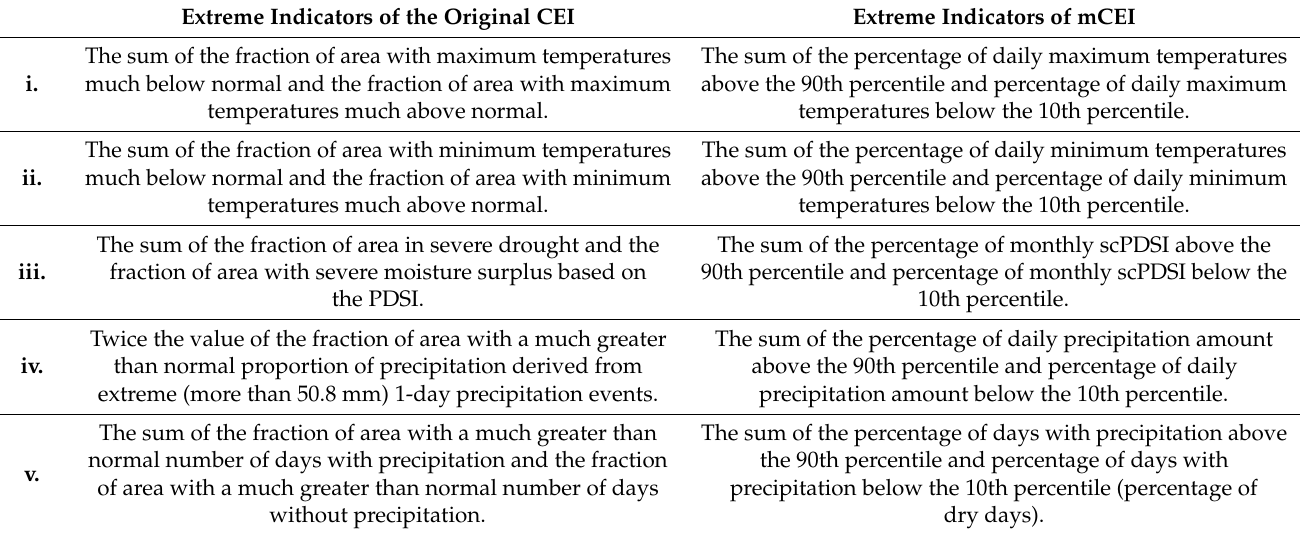
Figure 1. mCEI is the arithmetic average of five indicators that measure the annual temporal intensities of extreme climatic conditions. Table 1. Comparison of the indicators of CEI [18] and mCEI. Extreme Indicators of the Original CEI Extreme Indicators of